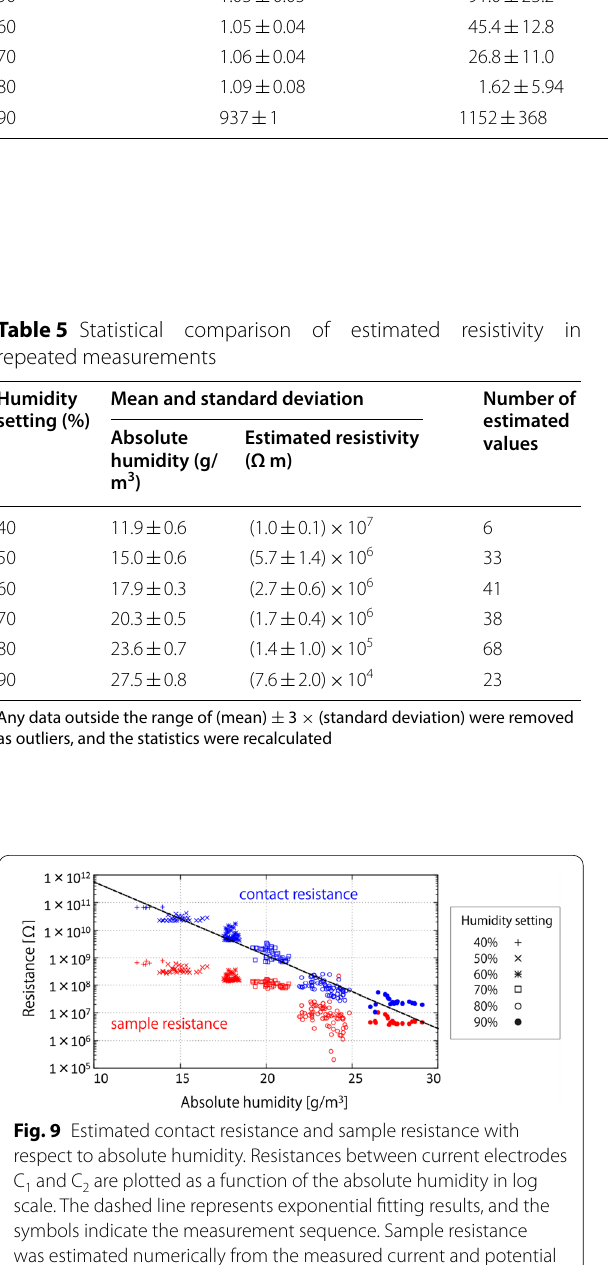
Fig. 9 Estimated contact resistance and sample resistance with respect to absolute humidity. Resistances between current electrodes C 1 and C 2 are plotted as a function of the absolute humidity in log scale. The dashed line represents exponential fitting results, and the symbols indicate the measurement sequence. Sample resistance was estimated numerically from the measured current and potential difference values in Fig. 8a, b. Contact resistance is half of the value obtained by subtracting the estimated sample resistance from the measured resistance value in Fig.